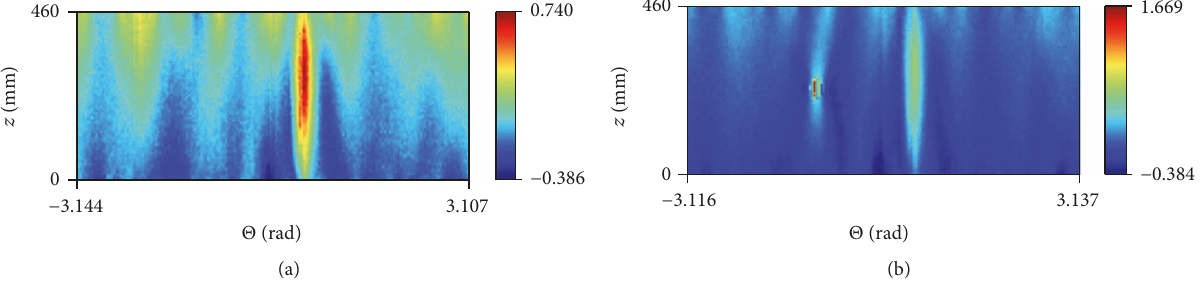
Figure 3: Imperfection scans by an internal laser scanner for R36 shell before (a) and after (b) introduction of cutout.